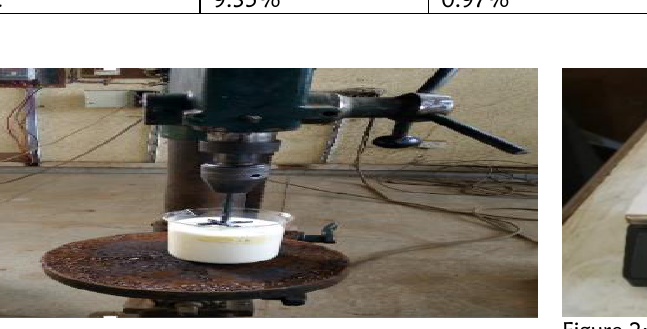
Figure 1: Stirring oil-in-water mixture